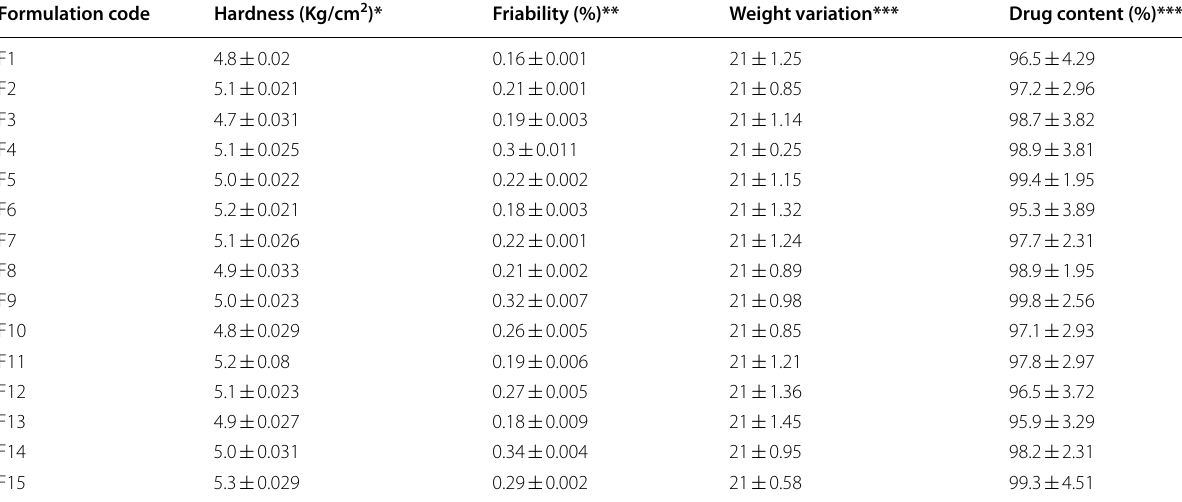
Table 4 Quality control test results of the prepared mucoadhesive minitablets